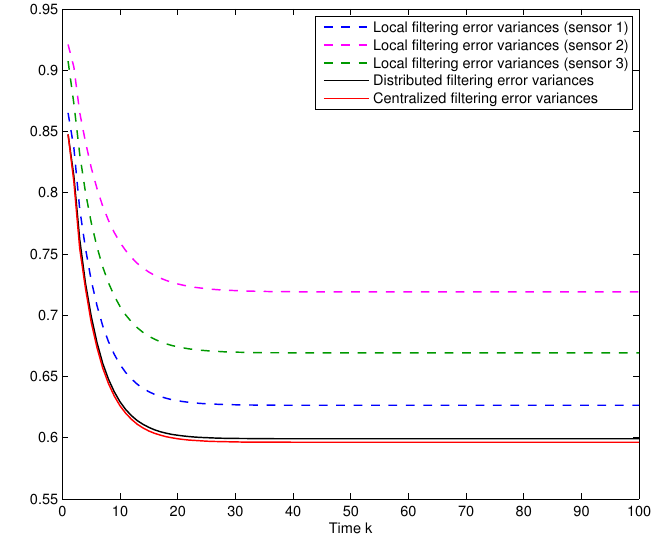
Figure 1. Filtering error variances for θ = 0.5, and γ ( i ) = 0.21, i = 1,2,3.